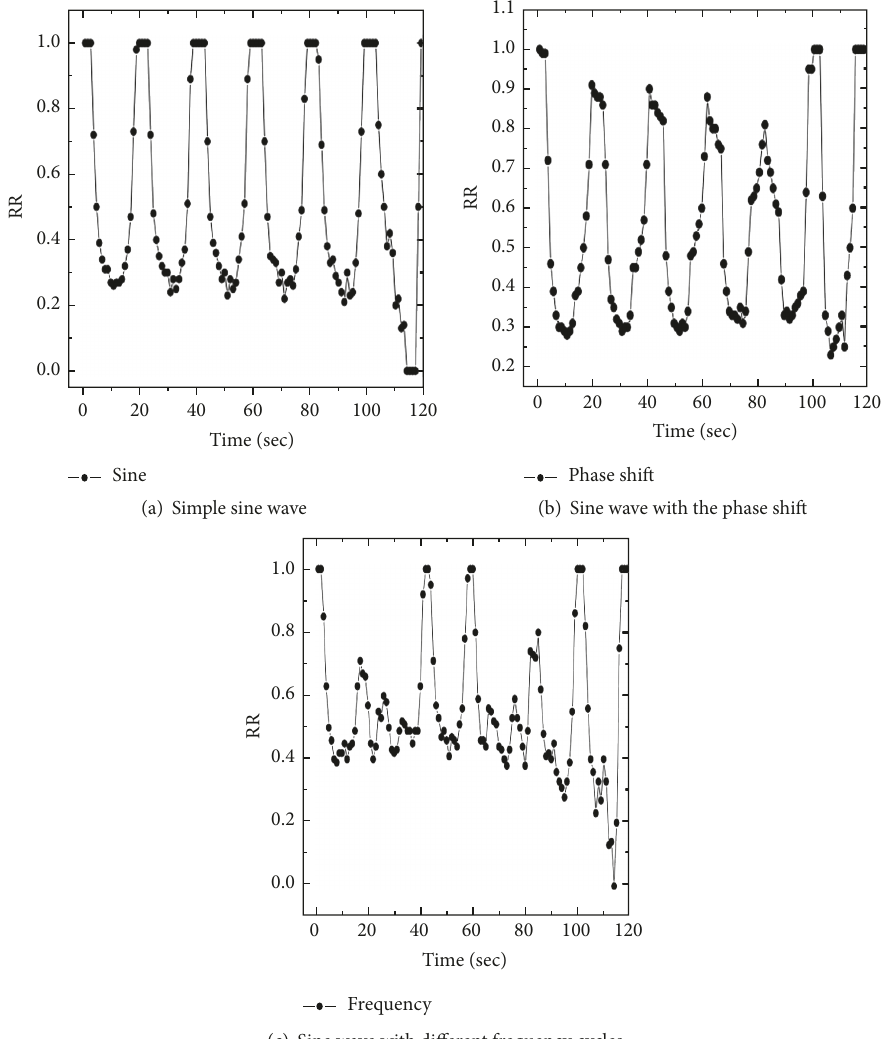
Figure 4: Recurrence rate (RR) or 𝑝(𝜏) curve for sine